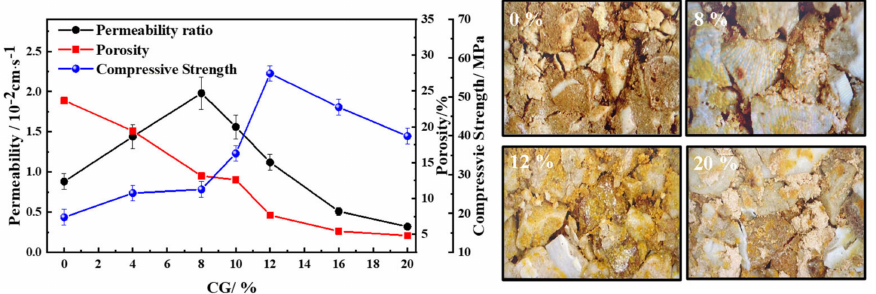
Figure 7. The trend of permeability coefficient, apparent porosity, and compressive strength with different CG contents at 1200 ◦ C.